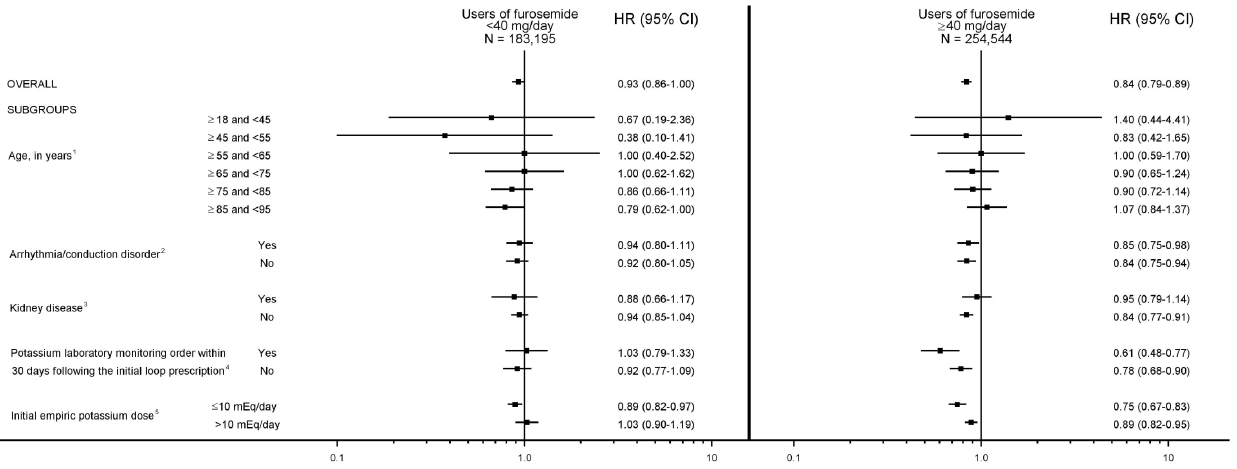
Figure 2. Risk of death for empiric potassium supplementation vs. no empiric potassium supplementation among furosemide initiators: propensity score-matched analyses examining patient subgroups. HR=hazard ratio; CI=confidence interval. p-values for the difference in effect estimates within stratum, in users of furosemide , 40 mg/day and in users of furosemide $ 40 mg/day. 1, p=0.86 and p=0.24, respectively. 2, p=0.75 and p=0.81, respectively. 3, p=0.66 and p=0.49, respectively. 4, p=0.74 and p=0.37, respectively. 5, p=0.08 and p , 0.01, respectively.